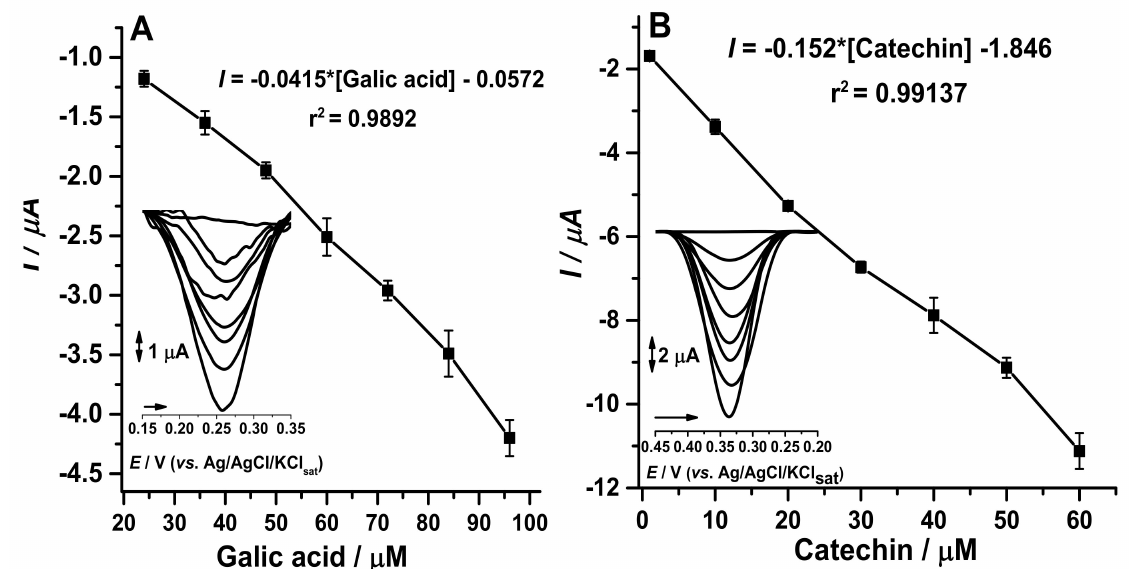
Figure 7. ( A ) Calibration curve with gallic acid from 1 µ M to 60 µ M at CP-50ME with LD = 0.14 µ M and LQ = 0.42 µ M. ( B ) Calibration curve with catechin from 1 to 60 µ M at CP-50ME with LD = 0.12 µ M and LQ = 0.38 µ M. Both performed in 100 mM sodium acetate buffer pH 5.0 after 2 min and 30 s of enzymatic